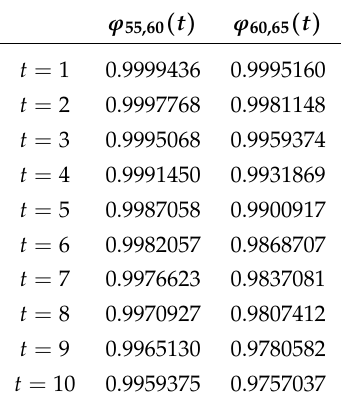
Table 3. Some values of ϕ y , z ( t ) .